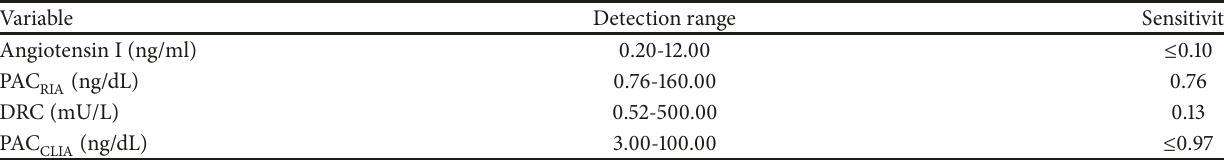
Table 2: Detection ranges and sensitivities of angiotensin I, DRC, and PAC measured by RIA and CLIA.